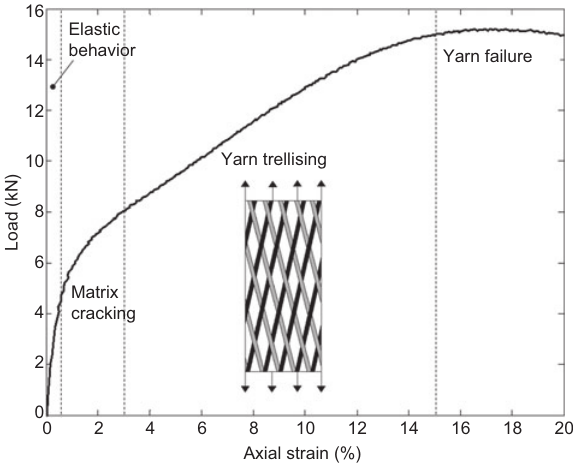
Figure 1 Typical off-axis response of woven composite.